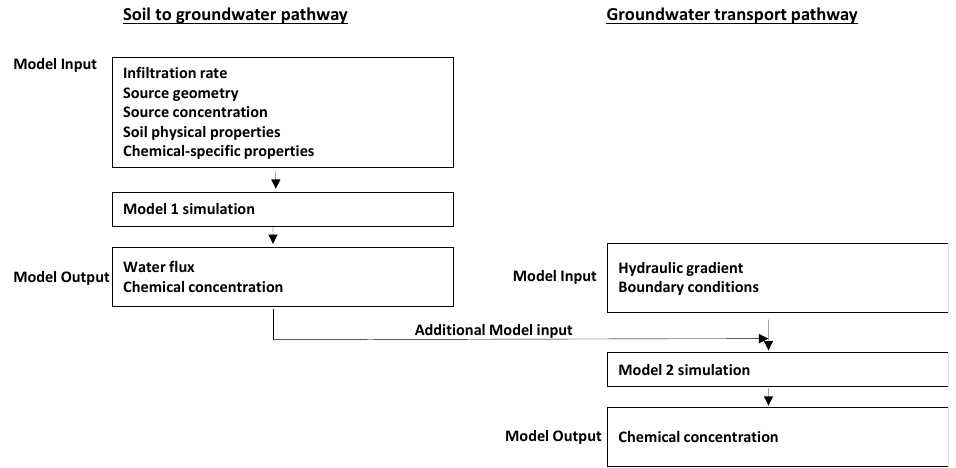
Figure 1. Flowchart for risk-based fate and transport simulations at contaminated sites.